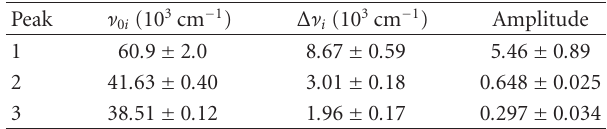
Table 2: Best-fitted parameters of the optical absorption spectra of thin sample of topaz heated at 200 ◦ C for Gaussian line shapes. The Gaussian amplitudes are given in absorbance units.